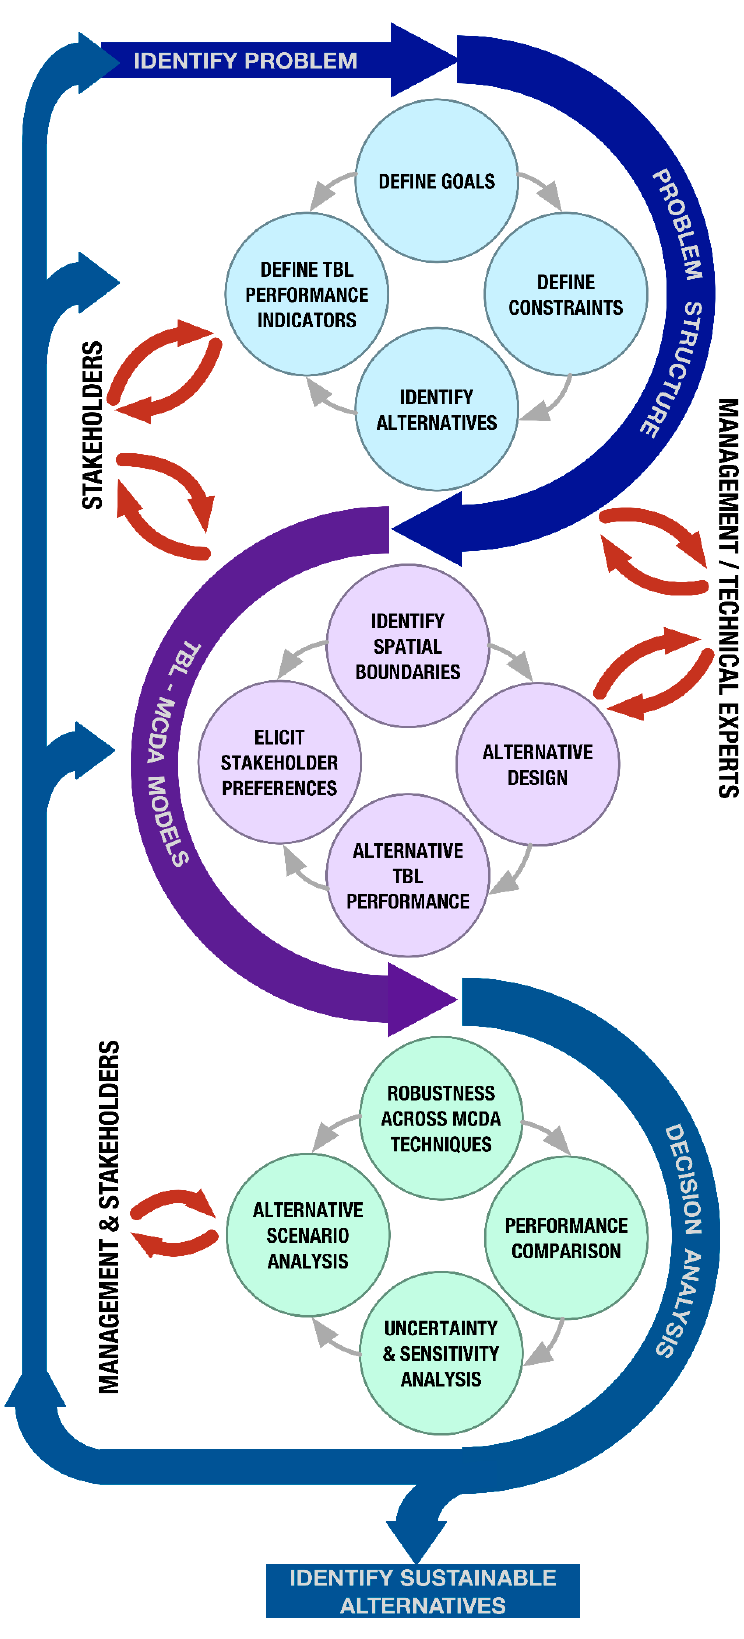
Figure 2. Collaborative, Risk-informed, Triple bottom line-Multi-criteria decision analysis (CRTM) planning framework.